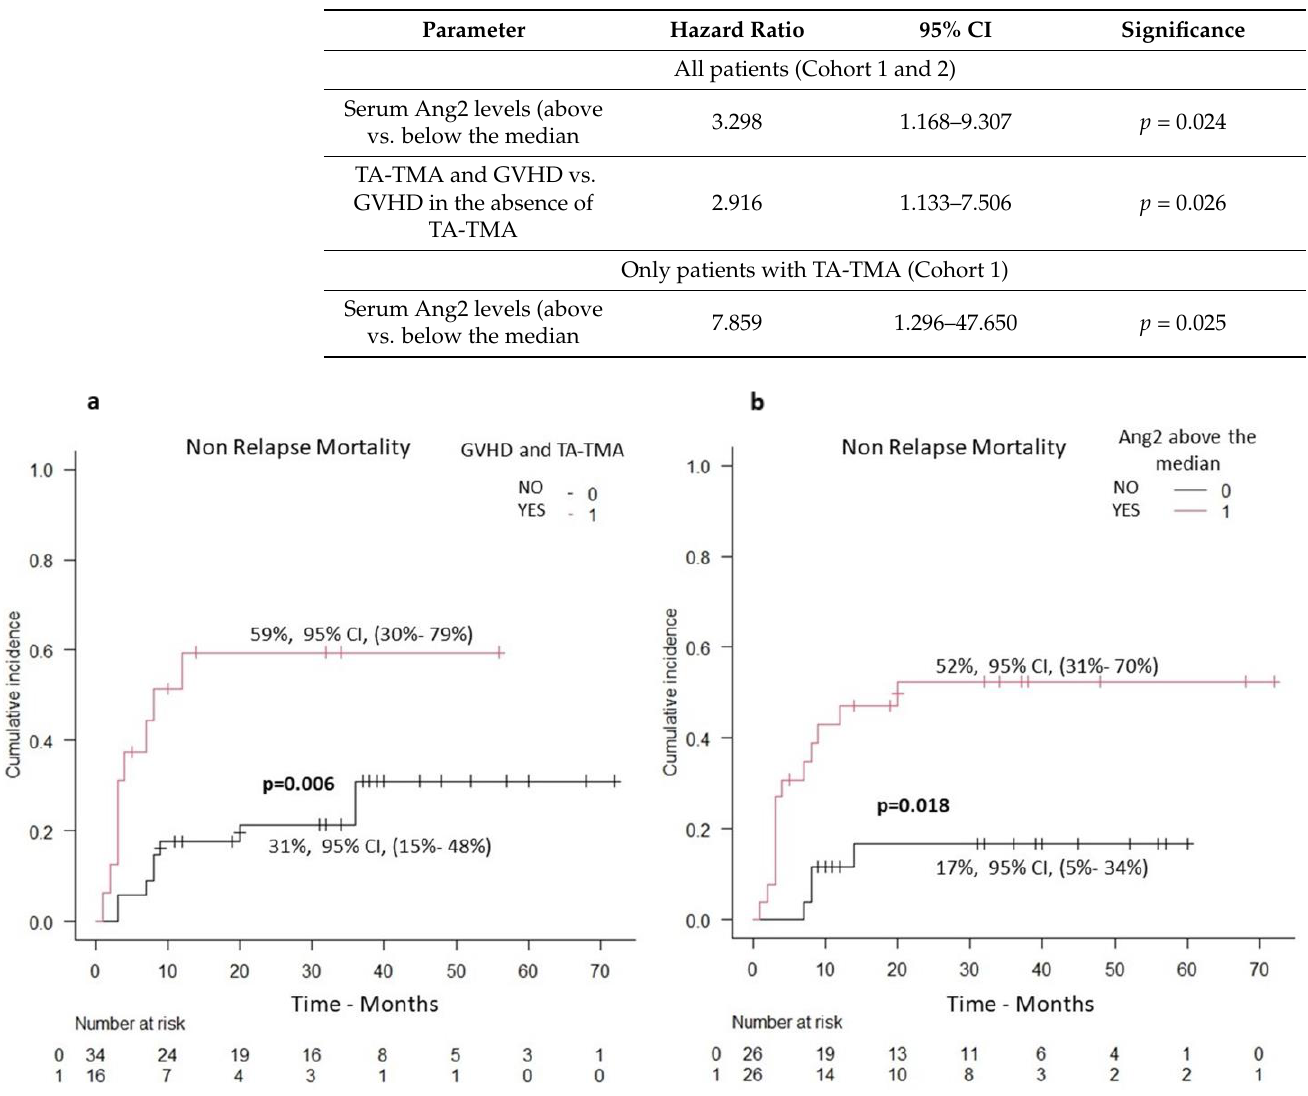
Figure 3. Non-relapse mortality (n = 52 patients): ( a ) patients with TMA and concurrent GVHD versus patients with GVHD in the absence of TMA (increased NRM in the group of patients with TMA and concurrent GVHD), ( b ) patients with serum Ang2 levels above versus below the median (increased NRM in the group of patients with serum Ang2 levels above the median).